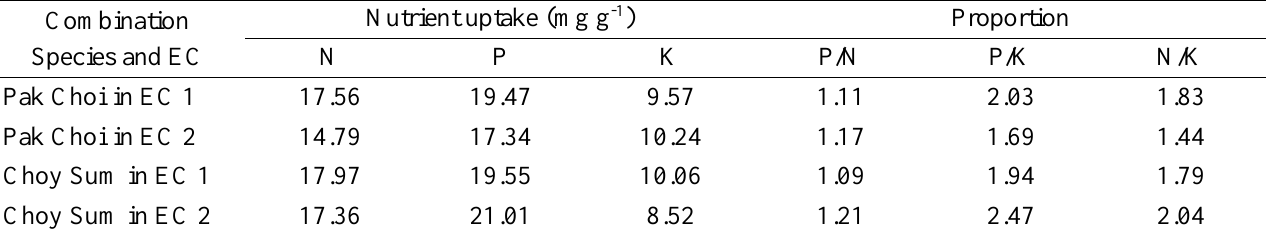
Table 4. N, P, K uptake (mg g -1 ) from total dry mass and nutrient proportion Combination Species and EC